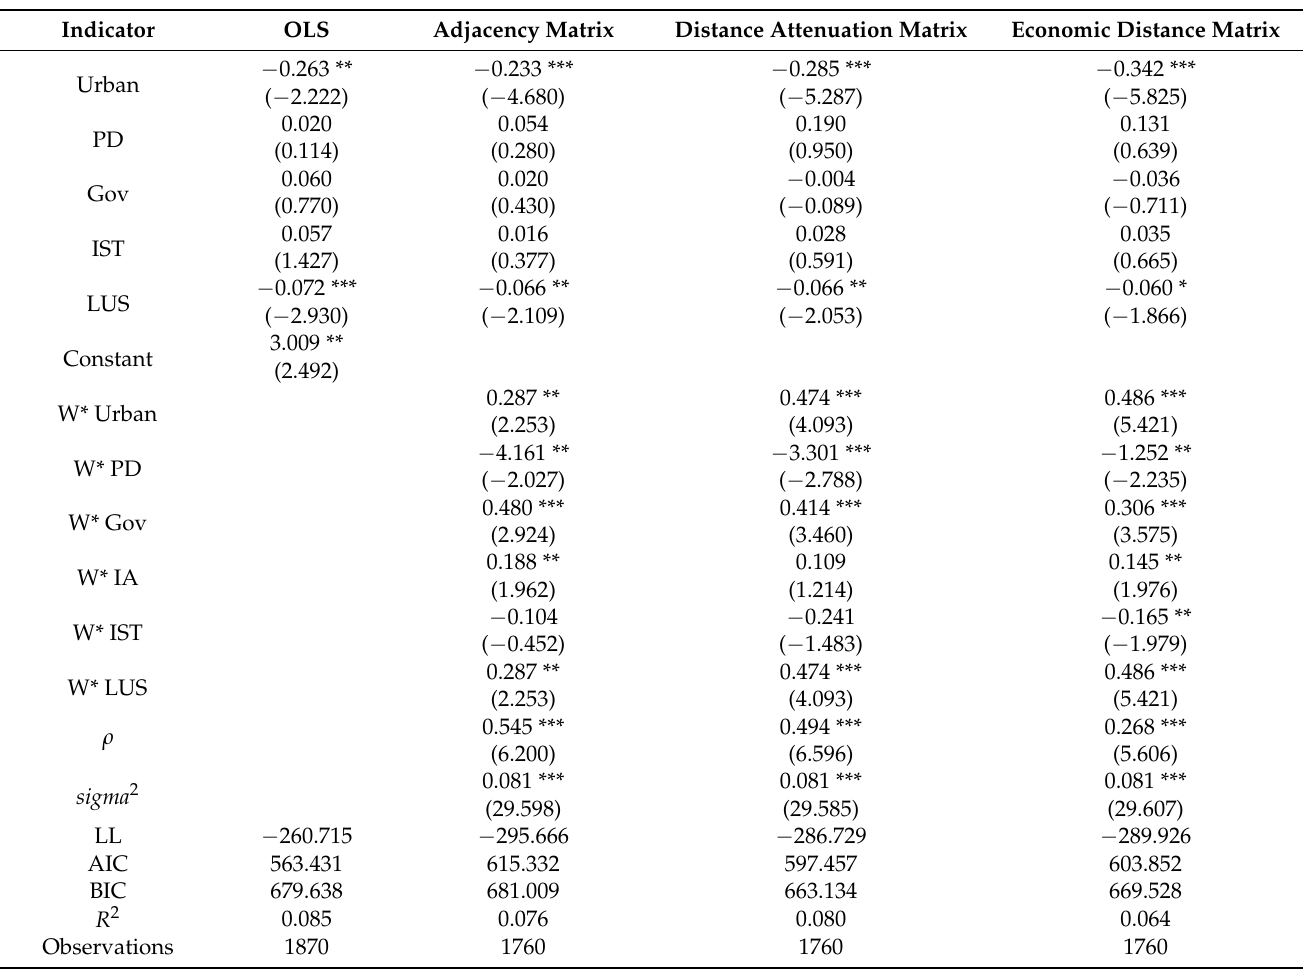
Table 5. Test results of spatial Dubin